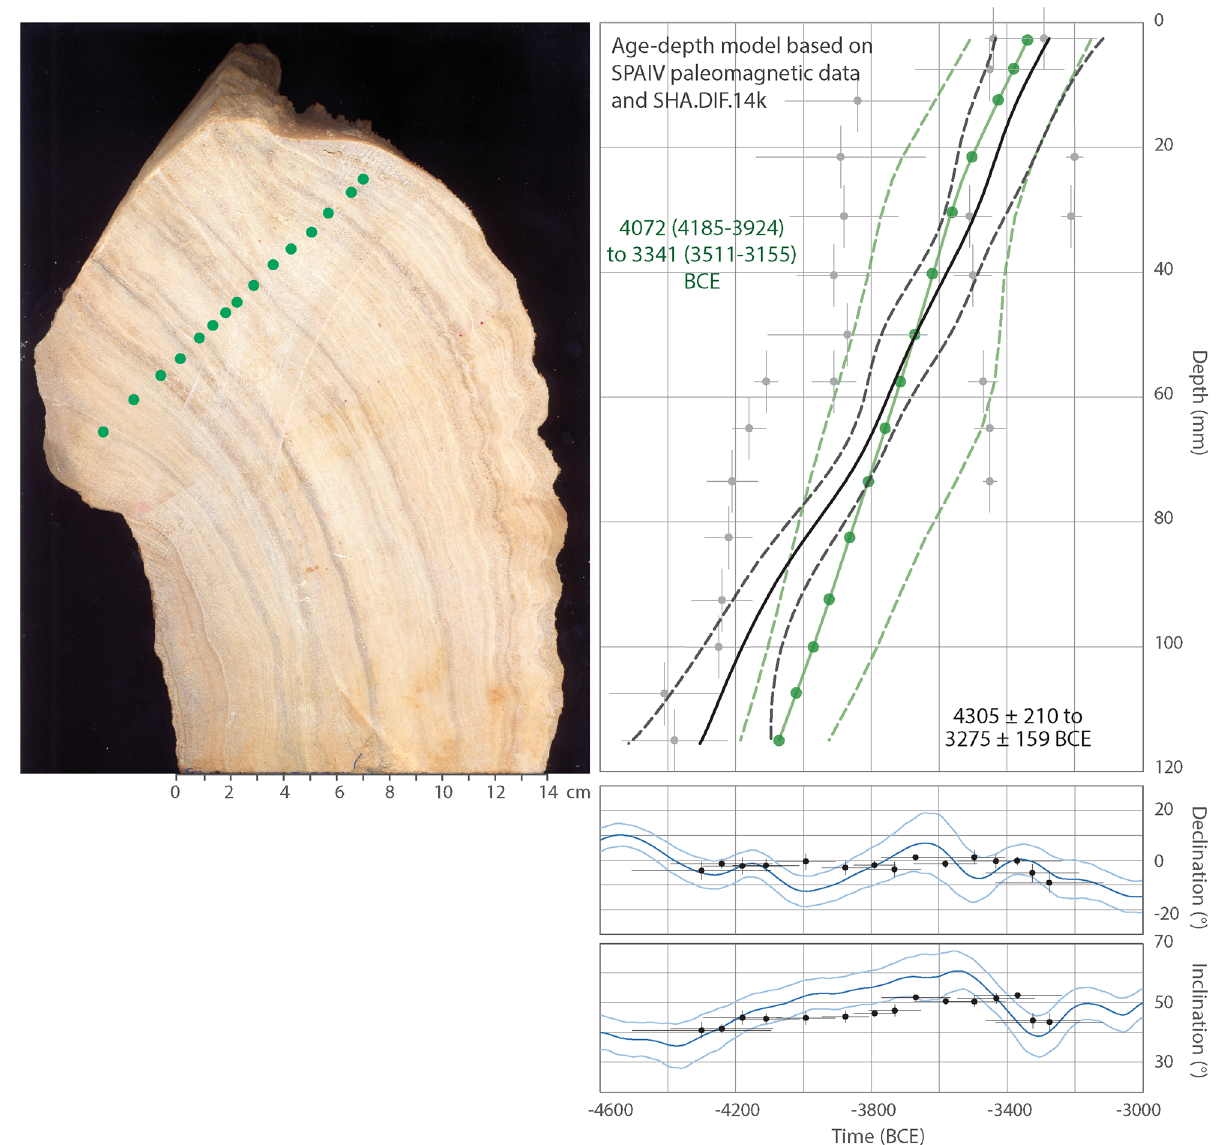
the PSV curve from the SHA.DIF.14k model, using our statistical bootstrapping analysis (in black). Age-depth model based on interpolated U-series ages (in green). Below is the position of the paleomagnetic data on the PSV curve after fitting. See Fig. 4 for legend. Green points in the speleothem picture represent the sample-based mean directions calculated by Ref. 26 in 15 calcite laminae for which ages were calculated based on U-series isochrons using the StalAge algorithm. All data errors and error bands are shown at 95% of